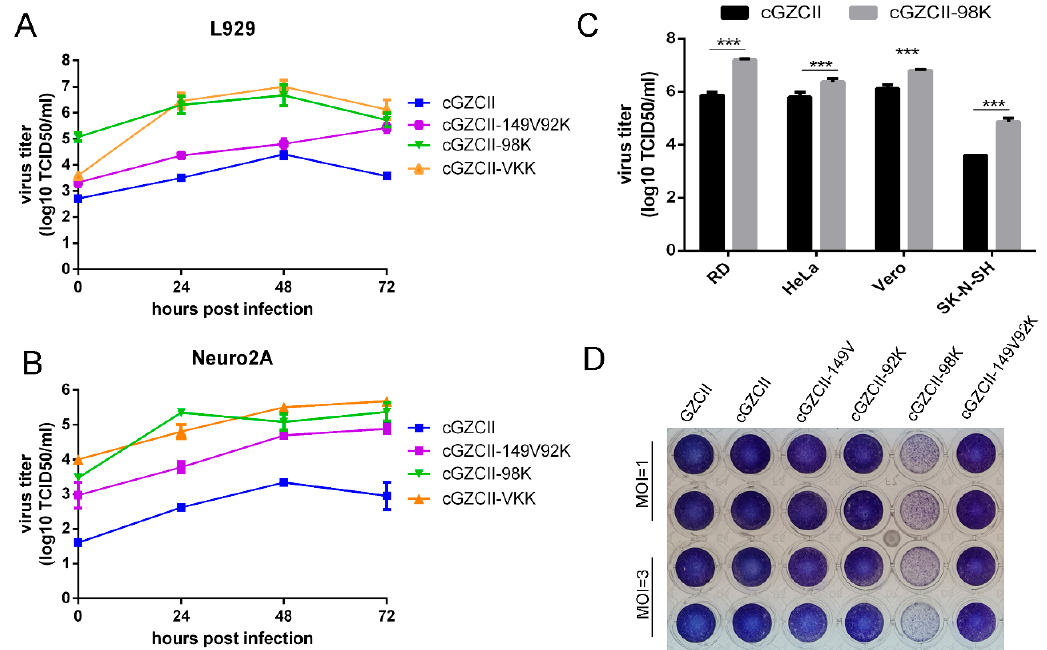
Figure 3. Replication kinetics of the recombinant GZCII viruses in cells. ( A ) Growth curves of GZCII variants in L929 or ( B ) Neuro2a cells (Multiplicity of infection = 0.1). ( C ) Vero, RD, HeLa, and SK-N-SH cells infected with cGZCII or cGZCII-98K virus (MOI = 0.1) were harvested at 24 h post-infection for virus titration in Vero cells (***: p < 0.001). ( D ) L929 cells in 96-well plates were infected with GZCII mutants (MOI = 1 or 3), fixed, and stained using crystal violet to assess cell cytotoxicity.